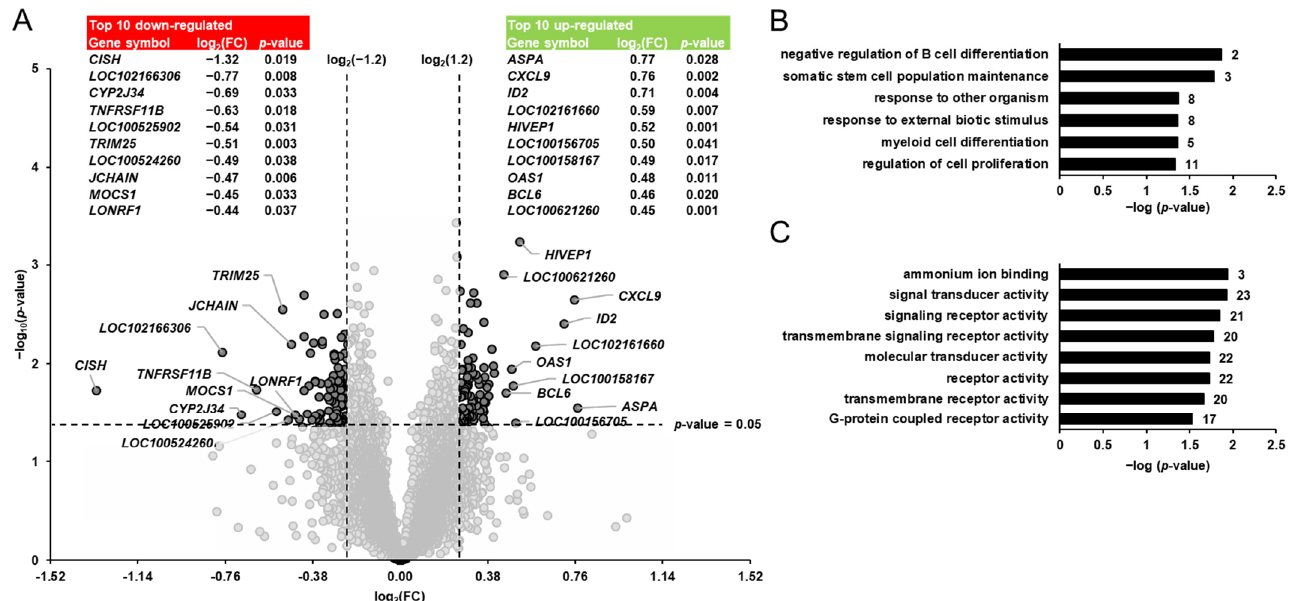
Figure 2. Identification of pivalate-regulated transcripts in the liver of pigs. ( A ): Volcano plot showing the differentially regulated hepatic transcripts between 5-week-old pigs orally administered either vehicle (group CON) or pivalate (group PIV) for 28 days. The double filtering criteria are indicated by horizontal ( p -value < 0.05) and vertical (FC: > log 2 (1.2) or <log 2 ( − 1.2)) dashed lines. Transcripts in the upper left and the upper right corner represent the downregulated and the upregulated transcripts, respectively. The top 10 up- and downregulated transcripts with log 2 (FC) and p -value are shown in tabular form. ( B , C ): Enriched gene ontology (GO) biological process ( B ) and molecular function ( C ) terms assigned to the genes that were differentially regulated between group PIV and group CON. GO terms are sorted by their enrichment p -values (EASE score) (top: lowest p -value; bottom: highest p -value). The number of genes is shown next to the bars.